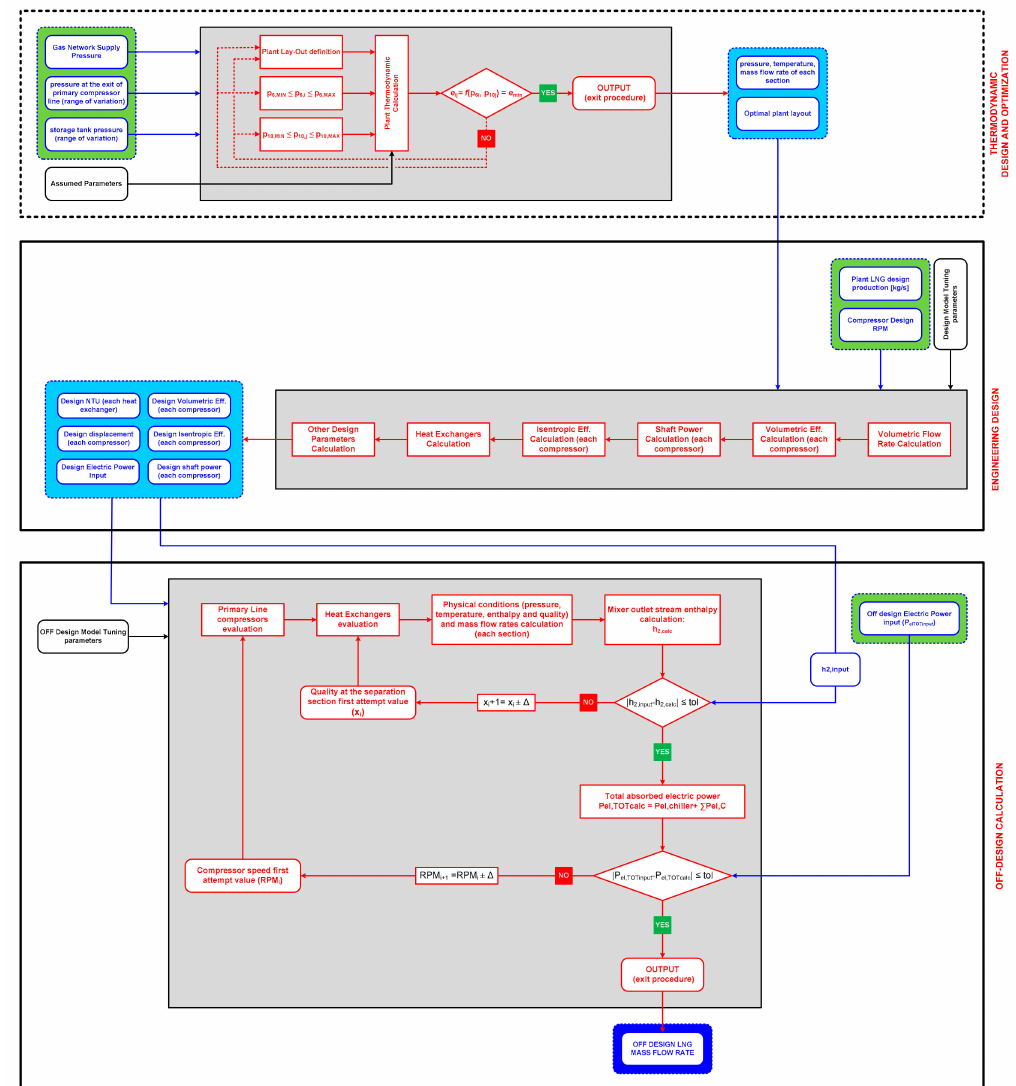
Figure 5. Flow chart of the developed calculation procedure consisting in (i) thermodynamic design and optimization, (ii) engineering design and (iii) o ff -design